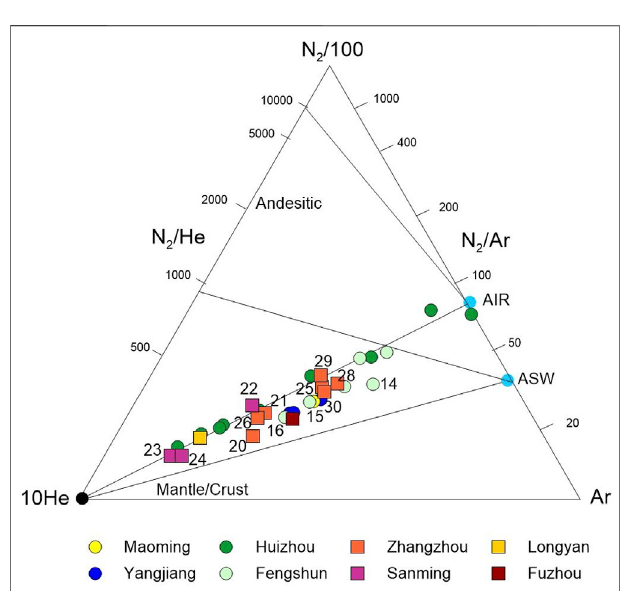
FIGURE 3 | Triangle plot of N 2 -He-Ar for hydrothermal volatiles from Southeast China. The AIR represents the atmospheric component, and the ASW represents air-saturated water.